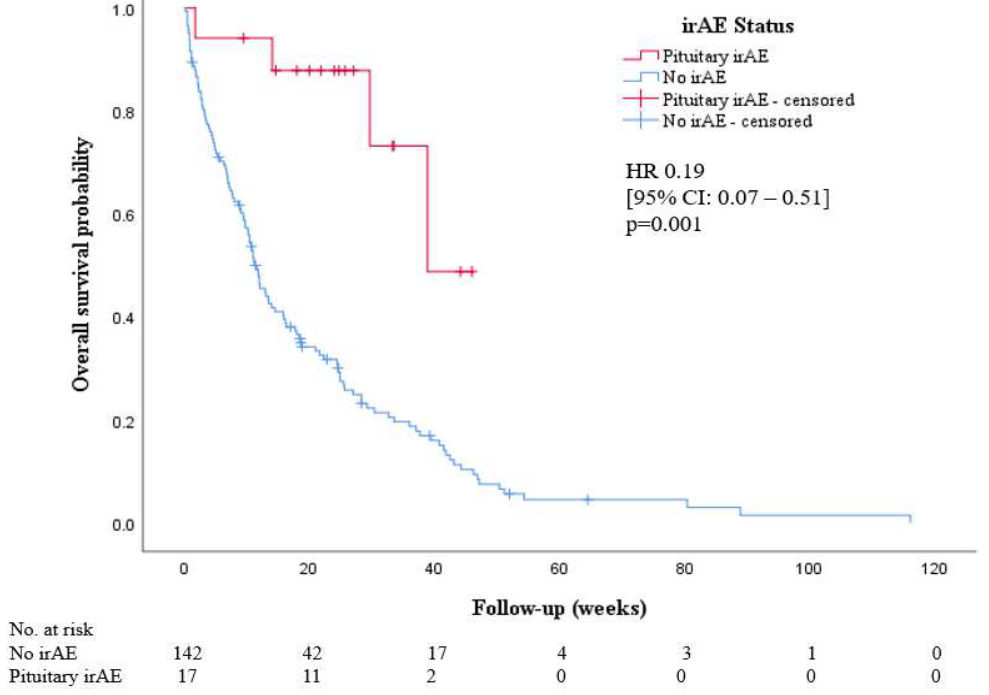
Three patients had insulin-dependent diabetes mellitus (IDDM) irAE. All three pa- tients were not known to have any pre-existing diabetes mellitus. The median time to the onset of IDDM after immunotherapy was started was 7.8 months (range: 1.4–9.1 months). At the onset of IDDM, median HbA1c was 9.5% (range: 7.8–9.8). The pancreatic beta-cell reserve was assessed in one of these patients. This patient had a low fasting C-peptide level of 131 pmol/L (normal: 364–1655 pmol/L) with a paired plasma glucose of 24.5 mmol/L (normal: 4–7.8 mmol/L). Anti-GAD antibody was negative in all three patients. Anti-islet cell antibody was negative in one patient and was not evaluated in the rest. All three patients presented with diabetic ketoacidosis (DKA) after the initiation of ICIs and had grade 4 irAE. 3.5. Survival Analysis and Treatment Response in Patients with Endocrine irAEs There was a significant difference in survival times between patients with any form of endocrine irAE and those without irAE (log-rank test p -value < 0.001). The estimated median survival times were 39 weeks in patients with endocrine irAE and 11.3 weeks in patients without irAE. The hazard ratio for death in patients with endocrine irAE was 0.34 (95% CI: 0.22–0.53, p < 0.001). When separate analysis was done on patients with lung cancer, there was also a sig- nificant difference in survival times between patients with endocrine irAE and patients without irAE (log-rank test p -value = 0.001). Among patients with lung cancer, the esti- mated median survival times were 33.5 weeks in patients with endocrine irAE and 14 weeks in patients without irAE. The hazard ratio in patients with endocrine irAE was